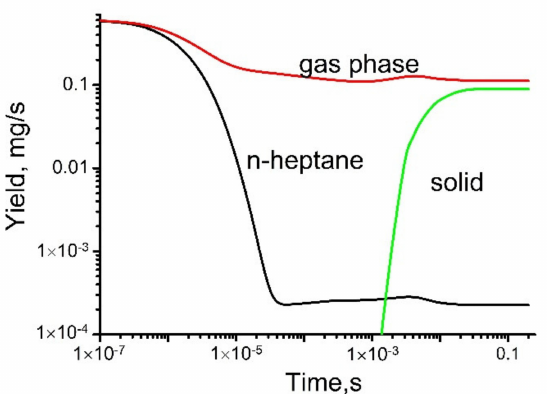
Figure 16. Evolution of the total yields of the gas-phase and solid products and rate of n -heptane